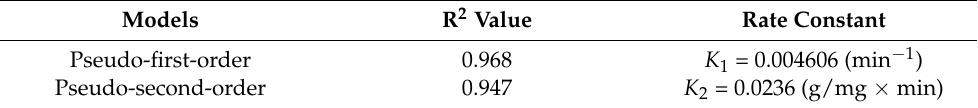
Table 4. Calculated values of R 2 and rate constant for kinetics models. Models R 2 Value Rate Constant Pseudo-first-order 0.968 K 1 = 0.004606 (min − 1 ) Pseudo-second-order